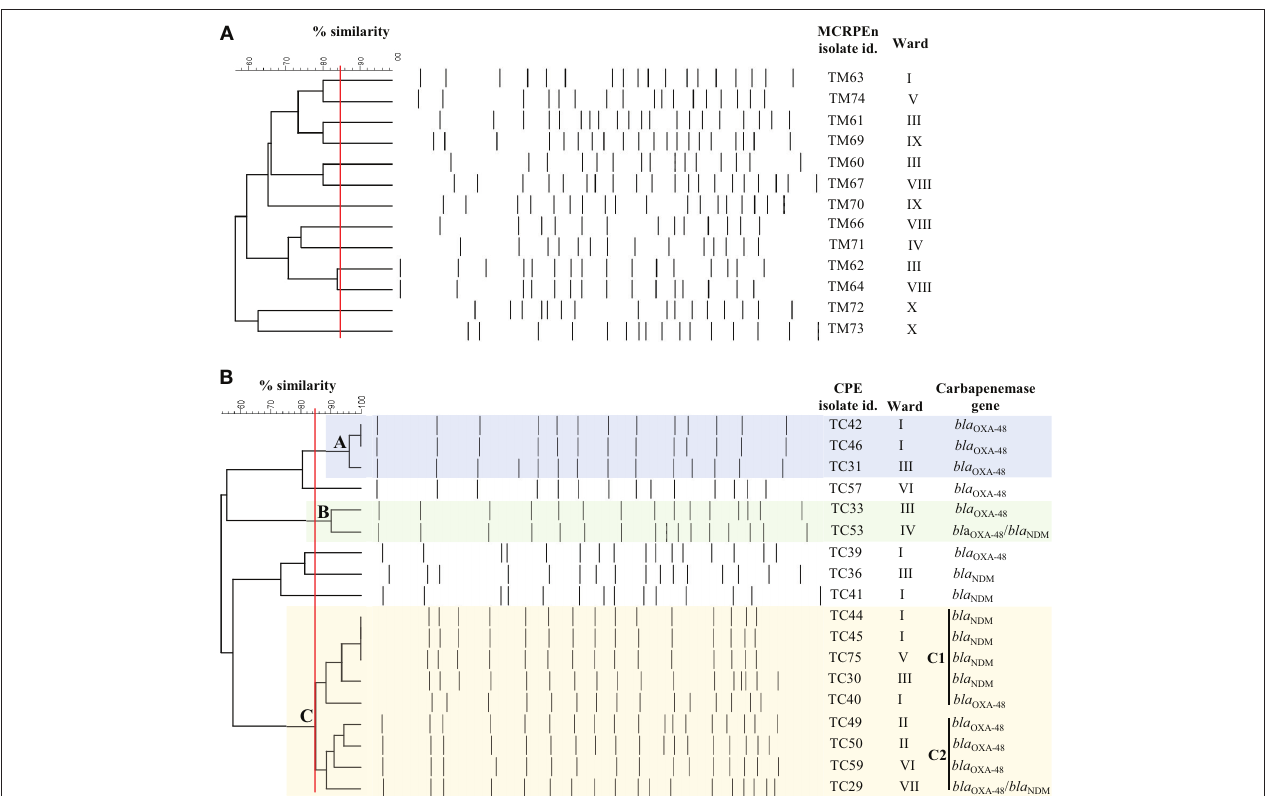
FIGURE 2 | PFGE analysis of Xba I-digested MCRPEn ( E. coli ) and CPE ( K. pneumoniae ) isolates. (A) Clonal relatedness of 13 mcr-1 -producing E. coli isolates. (B) Clonal relatedness of 18 carbapenemase-producing K. pneumoniae isolates. A, B, C1, and C2 represents the cluster of isolates with ≥ 85% similarity (red line). Isolates with Dice similarity coefficient ≥ 85% fall under one